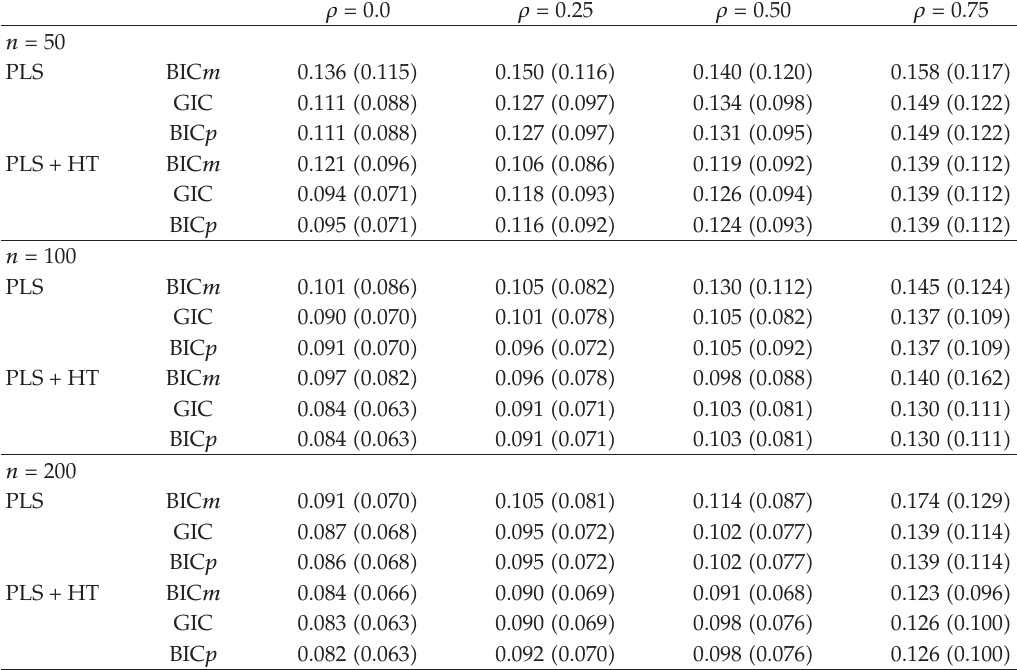
Table 3: Means (cid:3) standard deviations (cid:6) of first step ahead prediction errors. ρ (cid:7) 0 . 0 ρ (cid:7) 0 . 25 ρ (cid:7) 0 . 50 ρ (cid:7) 0 .